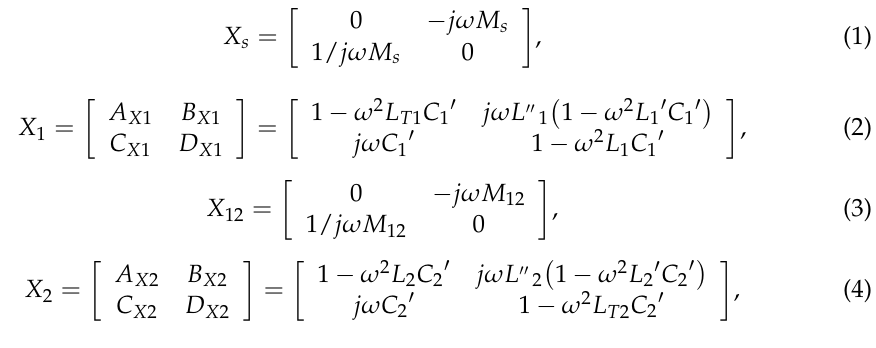
Figure 2. Modified equivalent circuit obtained by applying T-transformation to each coupling unit.